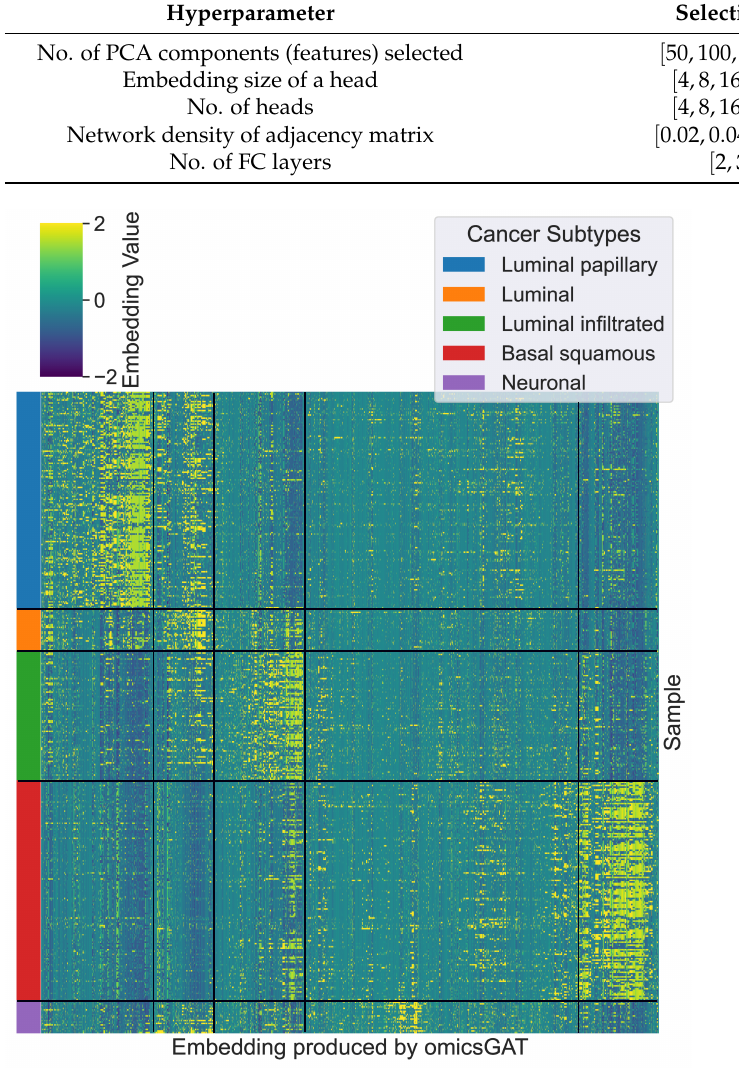
Figure 2. The embeddings generated by omicsGAT are clustered into the corresponding cancer